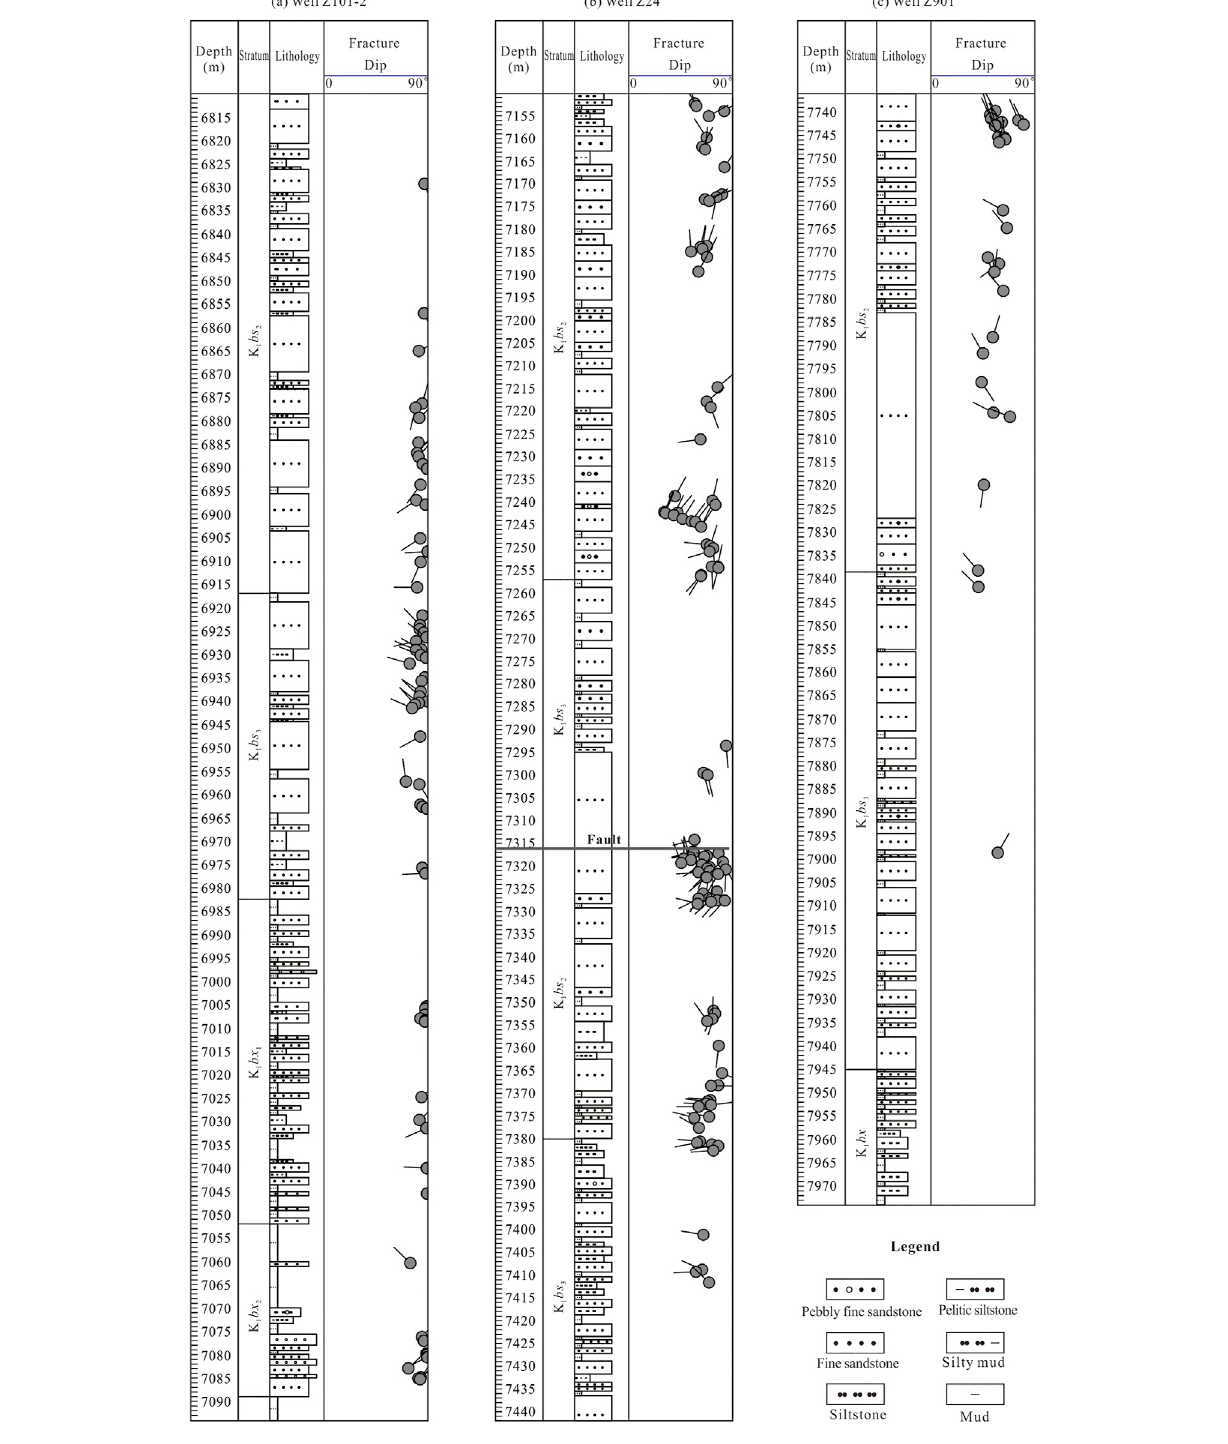
Frontiers in Earth Science |